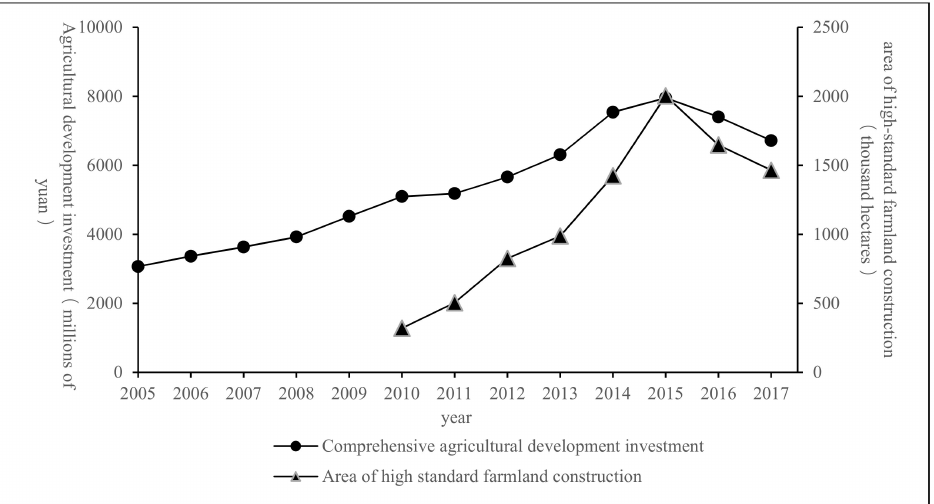
Figure 3. Agricultural investment and high-standard farmland construction area.